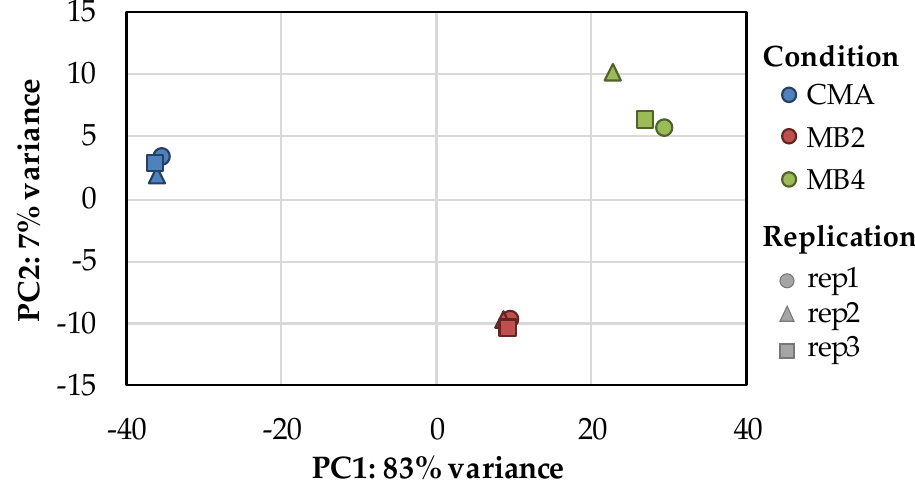
Principal component analysis (PCA) was performed for each sample according to the expression to observe similarities between sample groups (Figure 2). The three replicates of each group (CMA, MB2 and MB4) were gathered with close distance, but different treatment groups separated from others at a long distance, indicating good repeatability data.